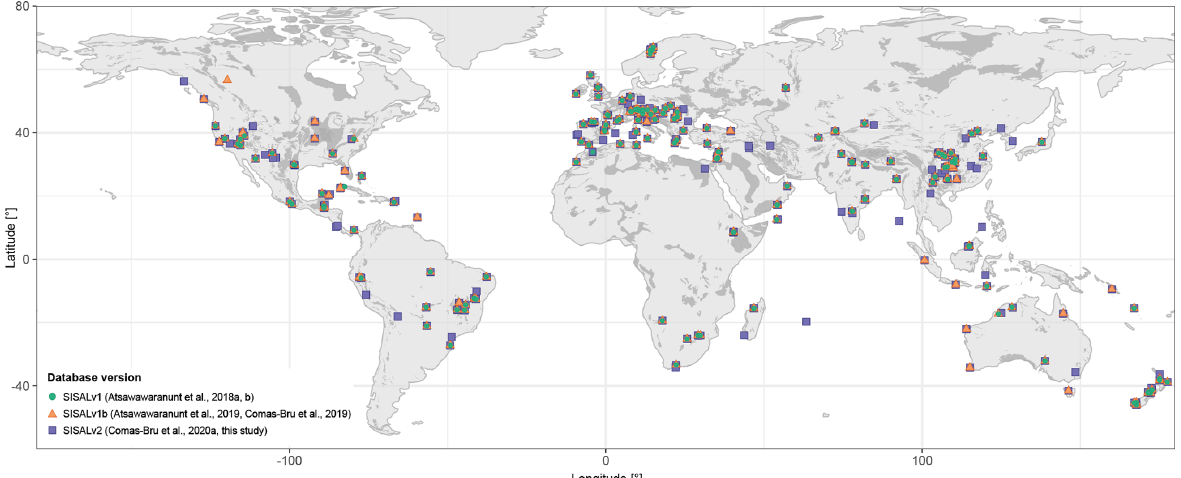
Figure 2. Cave sites included in the version 1, 1b and 2 of the SISAL database on the World Karst Aquifer Map (WOKAM; Goldscheider et al.,